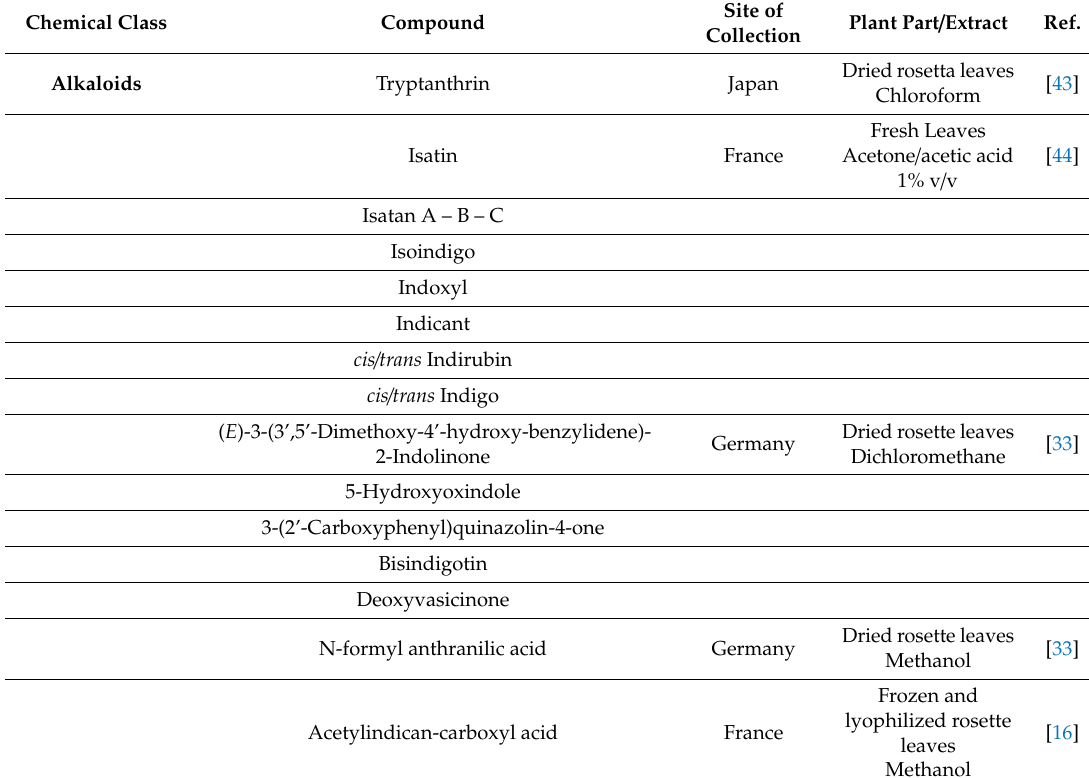
Table 1. Phytochemical composition of I. tinctoria